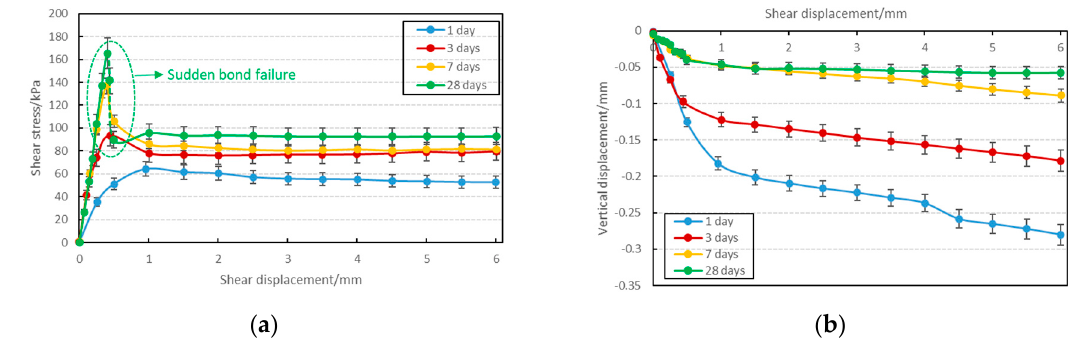
Figure 11. Plots of shear stress vs. shear displacement and vertical displacement vs. shear displacement of the FR-CPB / rock interface specimens treated for various periods (CPB made with 0.3% fibers; sulfate concentration of 5000 mg / L; normal stress of 100 kPa). ( a ) shear stress vs. shear displacement; ( b ) plots of vertical displacement vs. shear displacement.